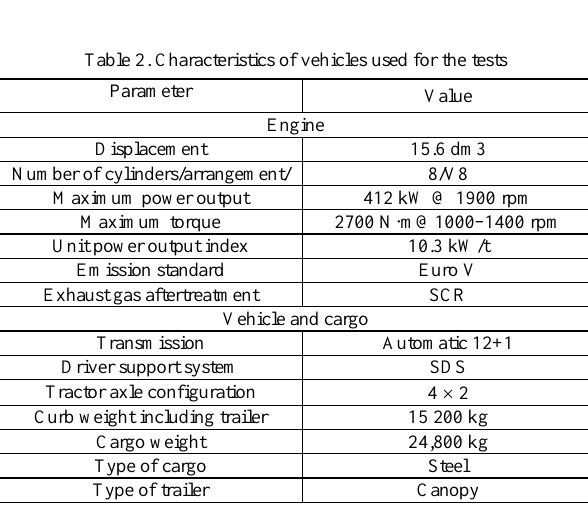
Fig. 2. The heavy-duty vehicle prepared to emission test